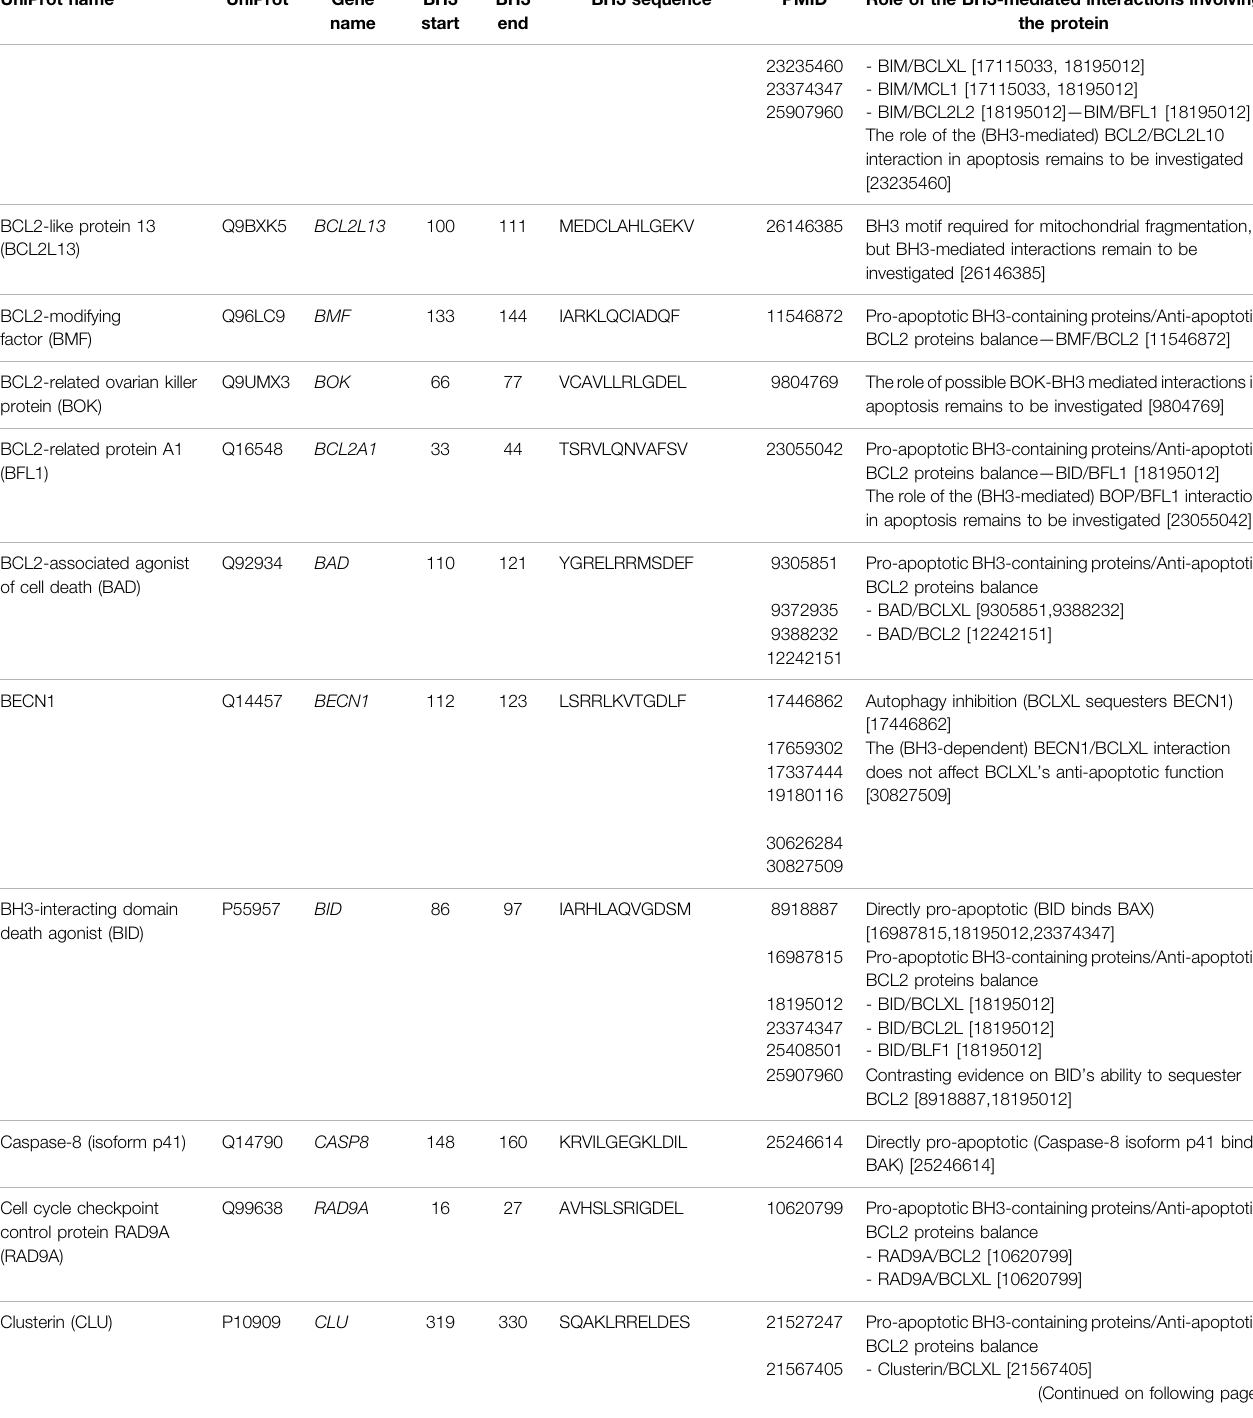
TABLE 1 | ( Continued ) Experimentally validated BH3 motifs from human proteins. We included all members of the BCL2 family (both anti-apoptotic and pro-apoptotic) and BH 3 -containing interactors whose BH3s were reported as not dispensable for binding BCL2 proteins through deletion of the motif or mutations in the critical hotspots. The “ PMIDs ” columncontainsthePubMedIDsofthepublicationswhereBH3-mediatedinteractionsinvolving theproteinsofinterestweredescribedorwherethefunctionalroleof such interactions was investigated (or both). The protein identi fi ers used throughout the text and in the fi gures are reported in parentheses in the fi rst column, after the UniProt name and the isoform speci fi cation (if available). For each interaction mentioned in the column “ Role of the BH3-mediated interactions involving the protein ” , the two